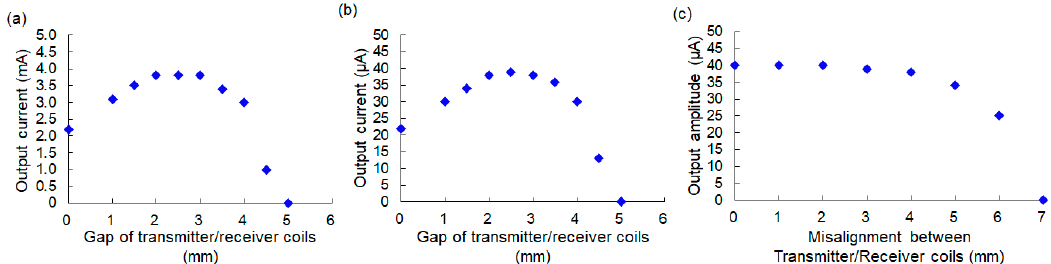
Figure 7. Experimental results for the output current from the receiver device: ( a ) Results with varying values of the vertical gap between the transmitter coil and the receiver coil when the output current was set on the maximum value in the experimental setup; ( b ) Results with varying values of the vertical gap between the transmitter coil and the receiver coil when the output current was set on µ A order for visual feedback experiments using a rat; ( c ) Results with varying values of the horizontal misalignment between the transmitter coil and the receiver coil.